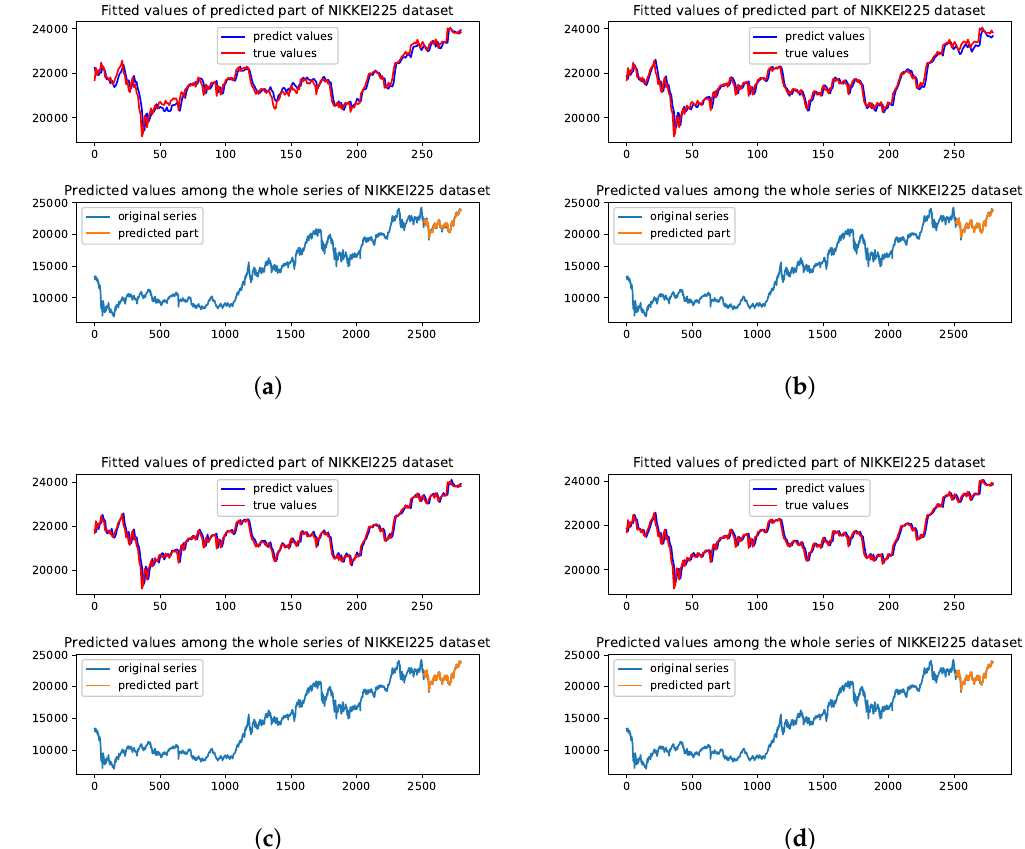
Figure 9. The visualization of the prediction results of the test part and among the whole series on the Nikkei225 dataset with four methods. ( a ) Predicted results of MLP model; ( b ) Predicted results of LSTM model; ( c ) Predicted results of CNN model; ( d ) Predicted results of UA